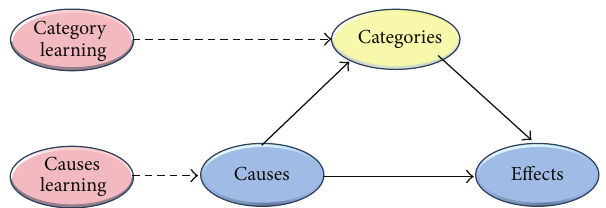
Figure 2: Enhanced strategy of category learning between causes and effects.